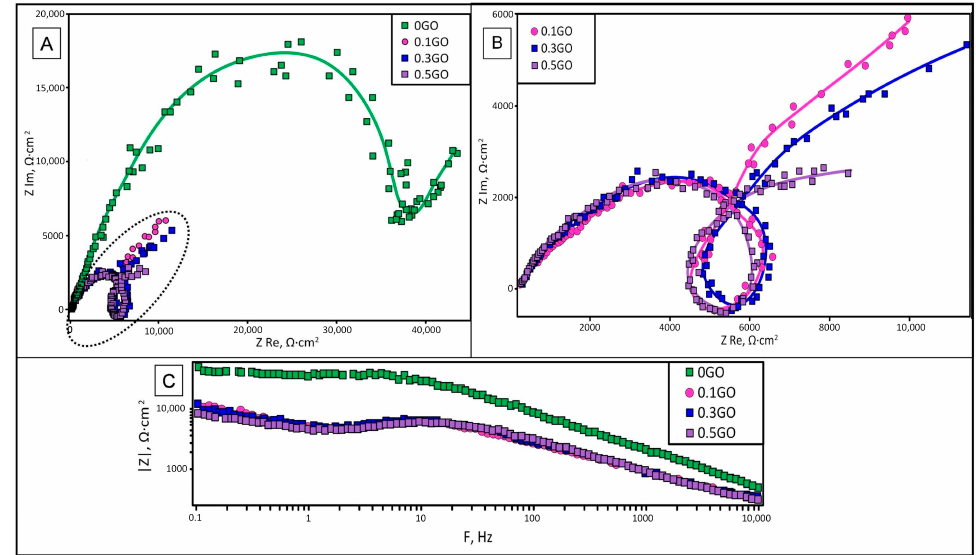
Figure 9. Nyquist plots ( A ), close-up of part of them ( B ), and Bode impedance plots ( C ) obtained in 3.5% NaCl solution for different MAO-coated samples.